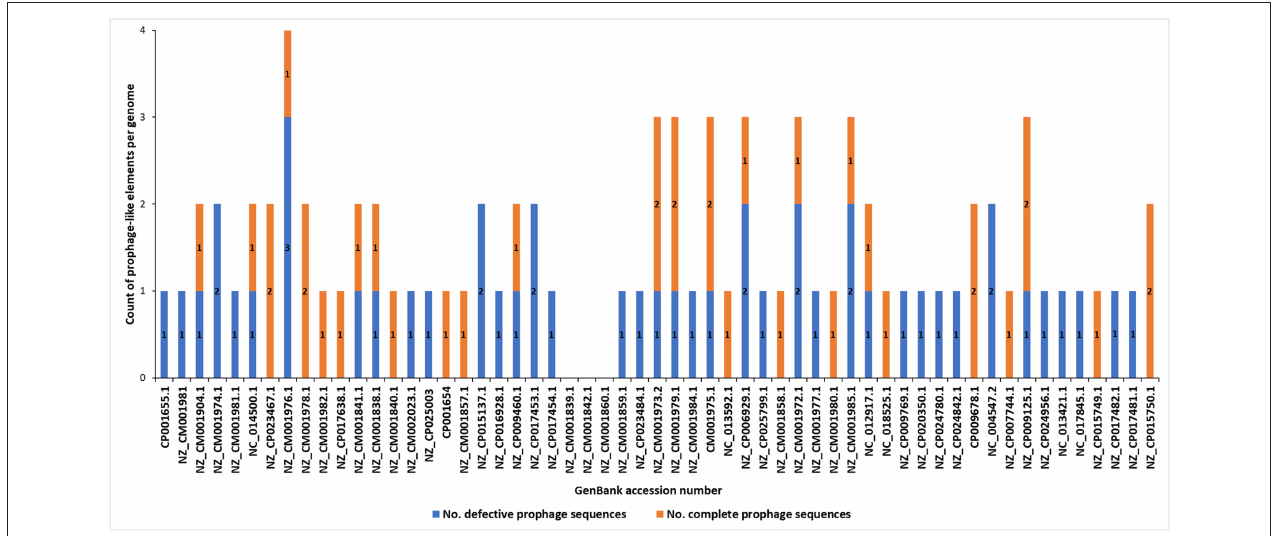
FIGURE 2 | Distribution of putatively defective prophage-like elements and seemingly intact prophages in 57 complete genomes of Soft Rot Pectobacteriaceae acquired from GenBank (NCBI). The prophage sequences were detected using PHASTER and PhiSpy and manually curated using BLAST (NCBI) using the pipeline presented in the Figure 1